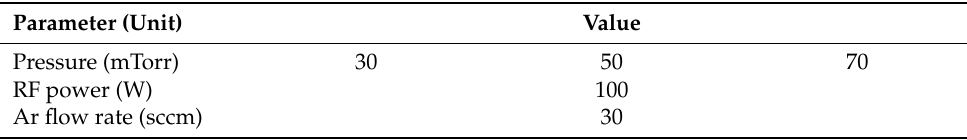
Table 2. Experiment conditions for pressure change.